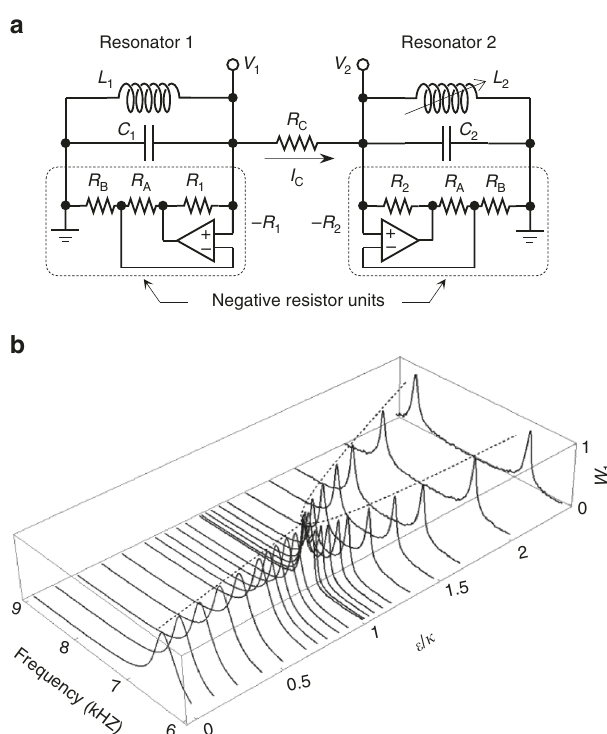
Fig. 2 APT-symmetric model circuit and its spectral property. a Circuit diagram of APT-symmetric LRC resonators. The circuit consists of two resistively coupled amplifying LRC resonators with negative resistor units. A variable inductor is used for L 2 to precisely control the energy-detuning parameter ε . b ε -dependent resonance-excitation spectrum W 1 ( f